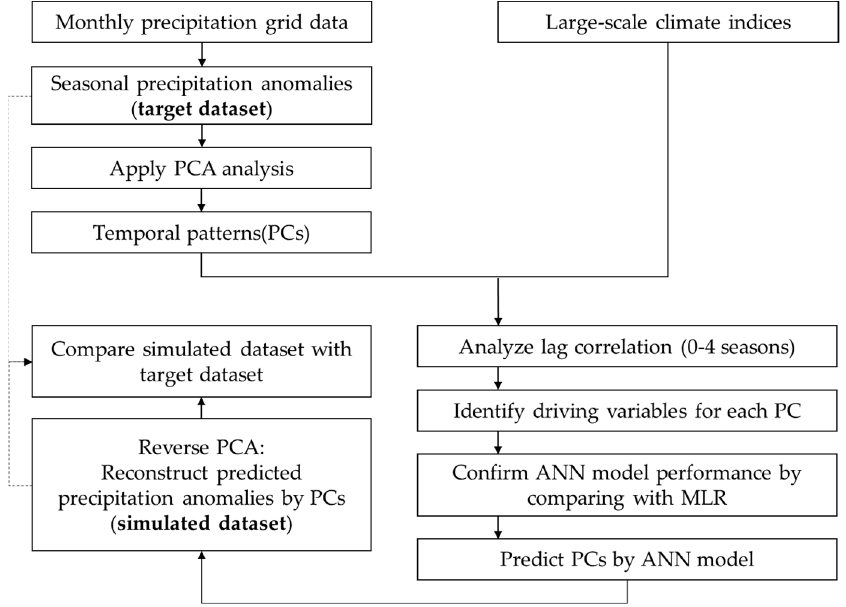
Figure 2. Flow chart of the principal component analysis and artificial neural network (PCA-ANN) model.